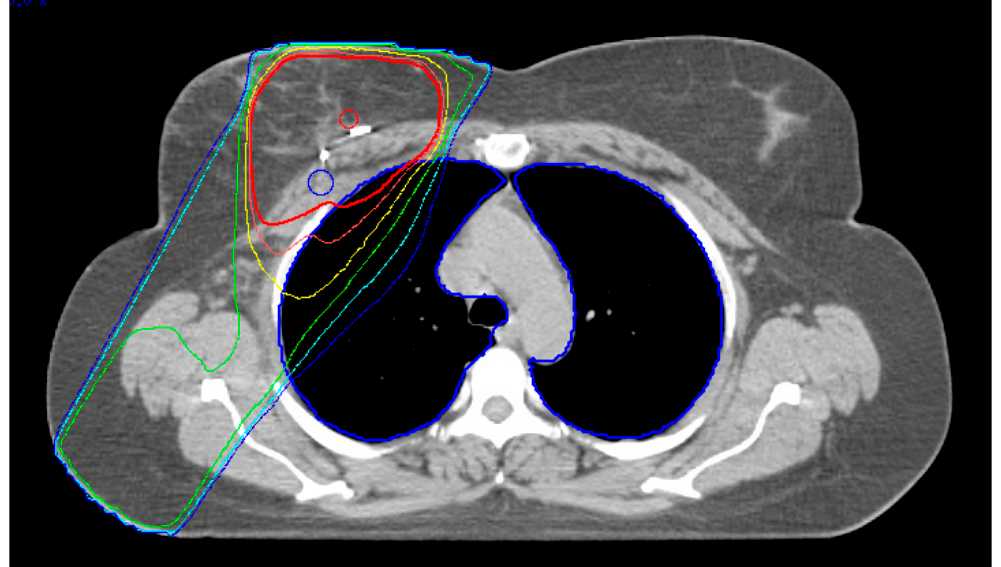
Figure 1. External beam partial breast irradiation treatment plan and dose distribution. APBI of a right-sided breast cancer after closed-cavity breast-conserving surgery with prepectoral tumor bed clips. Isodoses: red bold 95%, red thin 90%, yellow 80%, green 60%, light blue 40%, and dark blue 30%. Total lung organ-at-risk contour in dark blue.